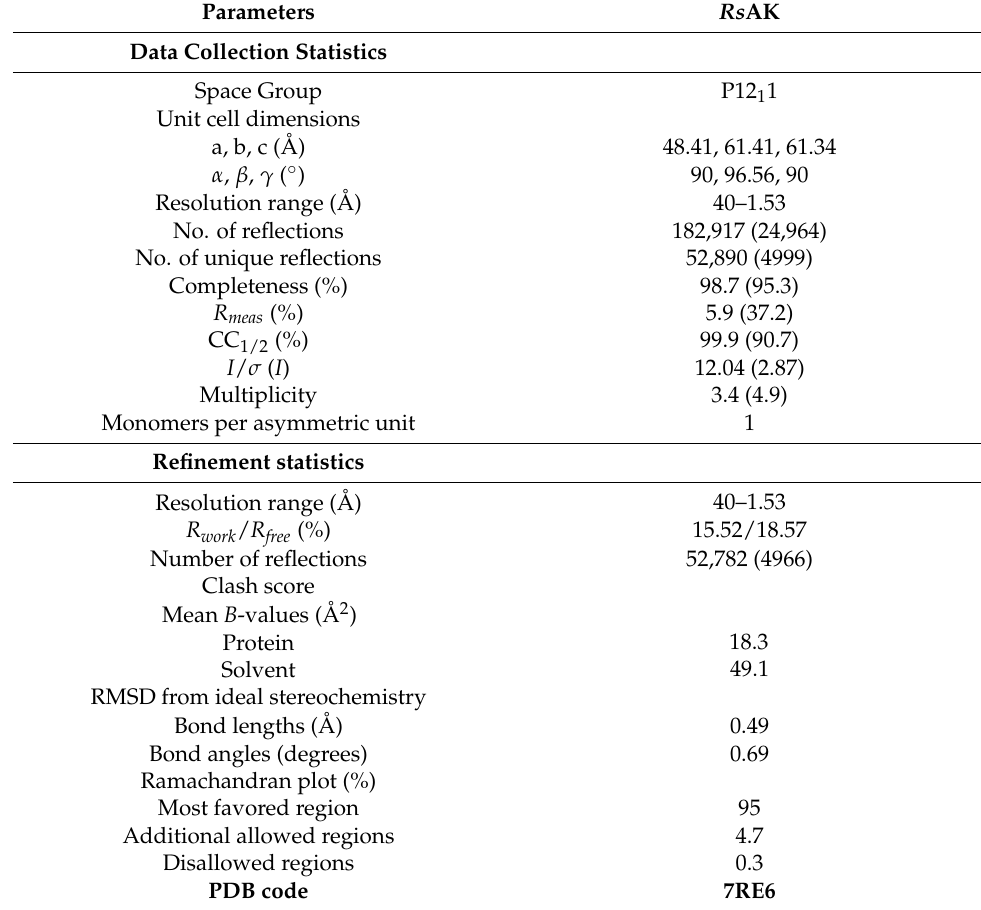
Table 2. X-ray data collection and refinement